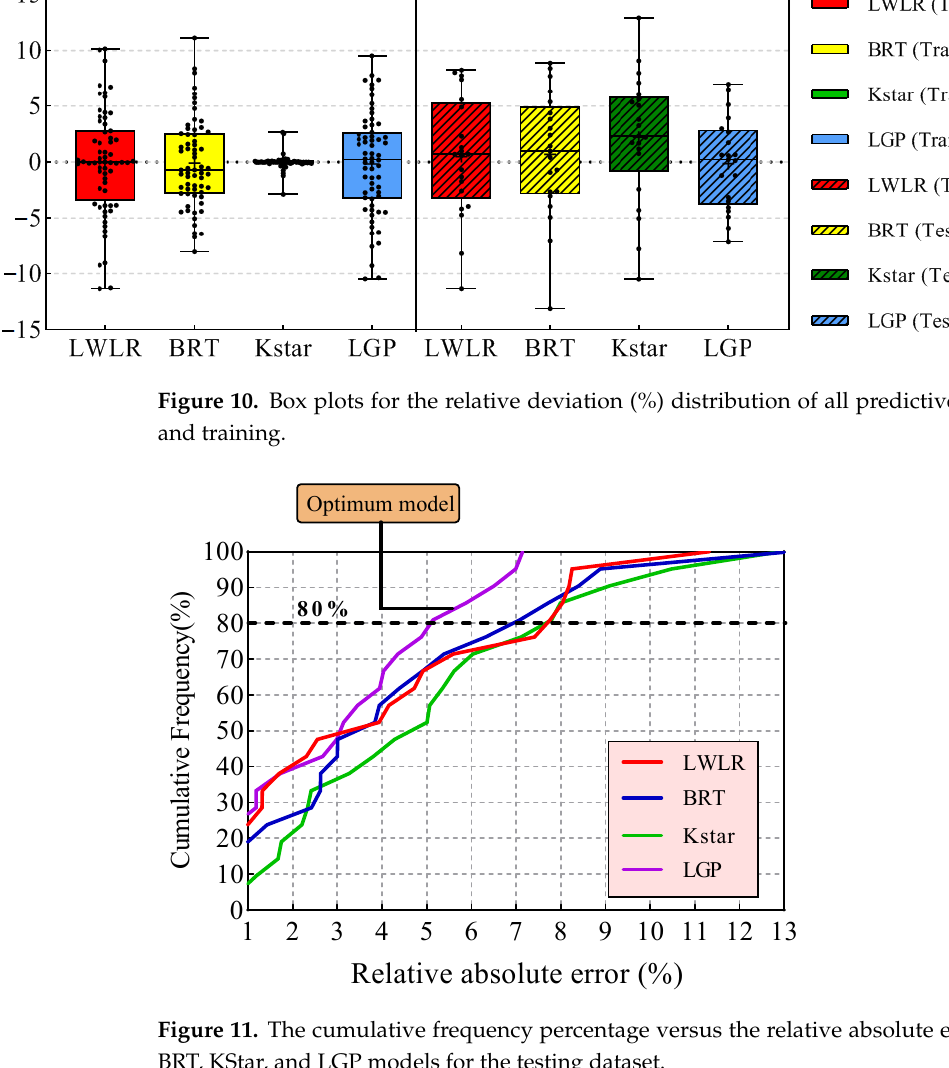
Table 5. The sensitivity analysis results for all possible situations. Metric All-R n All-V p All-Dry Density All-Is 50